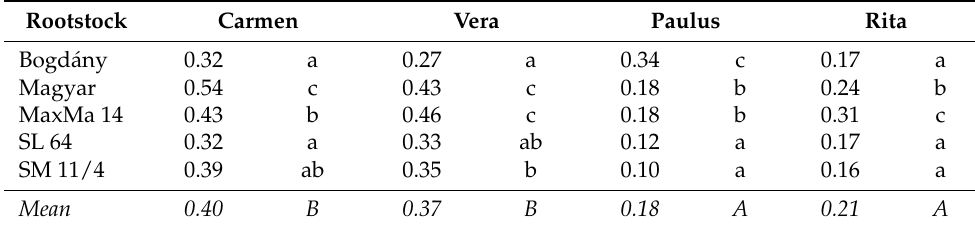
Table 4. The calculated CYE of trees related to TCSA (kg/cm 2 ).